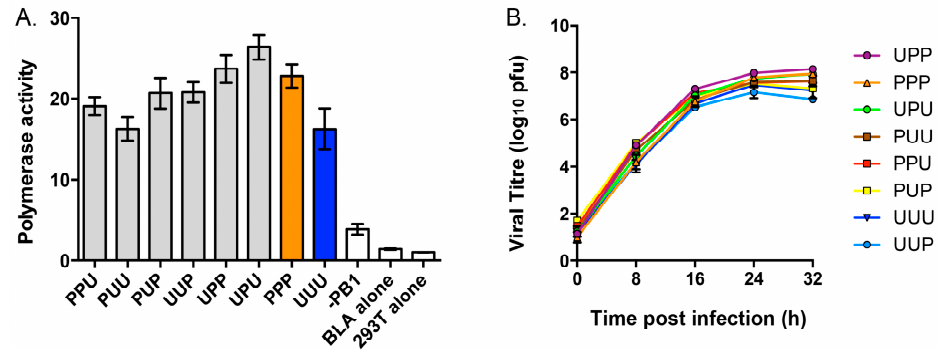
Figure 2. Effect of chimeric PB1 genes on polymerase activity and replication of PR8(Ud ‐ NA, chimeric PB1) viruses. ( A ) Minigenome assays were performed in 293T cells transfected with the pCAGGS ‐ BLA reporter gene, plasmids expressing the PR8 PB2, PA and NP genes, together with